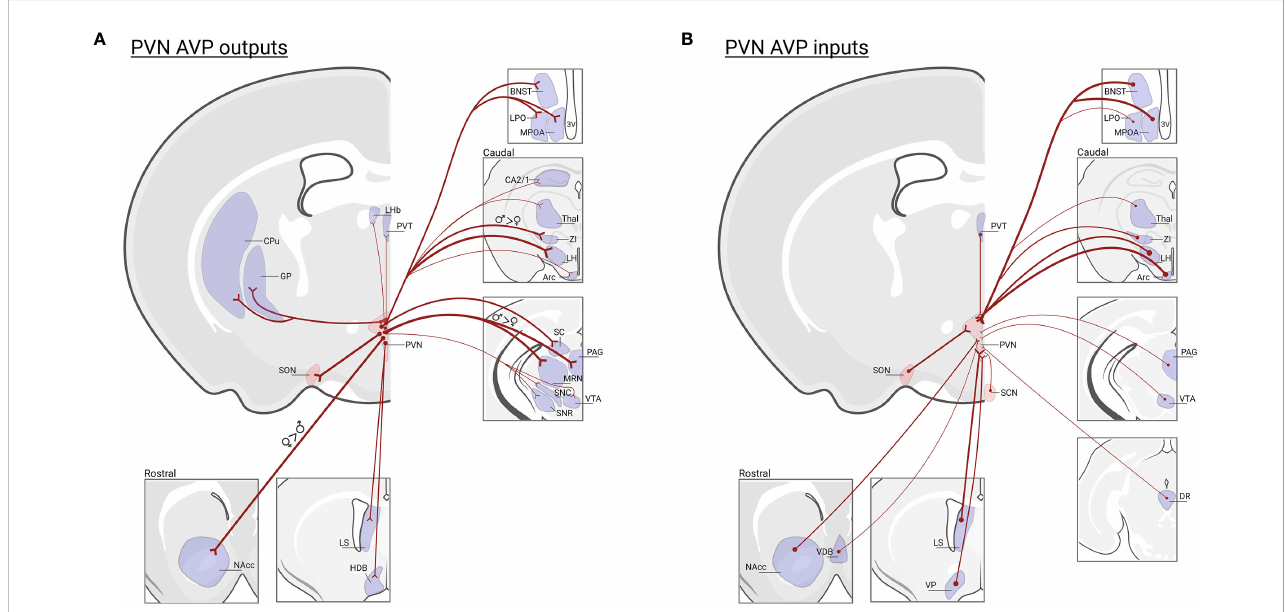
FIGURE 3 PVN AVP cell inputs and outputs in mice . (A) Regions that receive prominent input from vasopressin cells in the PVN: (NAcc)* nucleus accumbens; (LS) lateral septum; (HBD) horizontal diagonal band; (MPOA) medial preoptic area; (LPO) lateral preoptic area; (BNST) bed nucleus of the stria terminalis; (LHb) lateral habenula; (PVT) paraventricular nucleus of the thalamus; (GP) globus pallidus, (CPu) caudate putamen; (SON) supra optic nucleus; (CA2/1) hippocampus;(Thal) thalamus; (ZI) † zona interna; (LH) lateral hypothalamus; (Arc) arcuate nucleus; (SC) superior colliculus; (PAG) † , periaqueductal gray; (MRN) † , median raphe nucleus; (SNC) substantia nigra pars compacta; (SNR) substantia nigra reticulata; (VTA), ventral tegmental area; Data based on PVN AVP cell-speci fi c tracing (125) and the location of AVP-ir fi bers remaining after male gonadectomy or SCN lesions (46). Note that fi ber measurements do not determine AVP cell synapses in labeled regions. (B) Regions that send input to vasopressin cells in the PVN: NAcc, vertical diagonal band (VDB), LS, ventral pallidum (VP), BNST, MPOA, LPO, PVT, SON, suprachiasmatic nucleus (SCN), Thal, ZI, LH, Arc, PAG, VTA, dorsal raphe (DR); data based